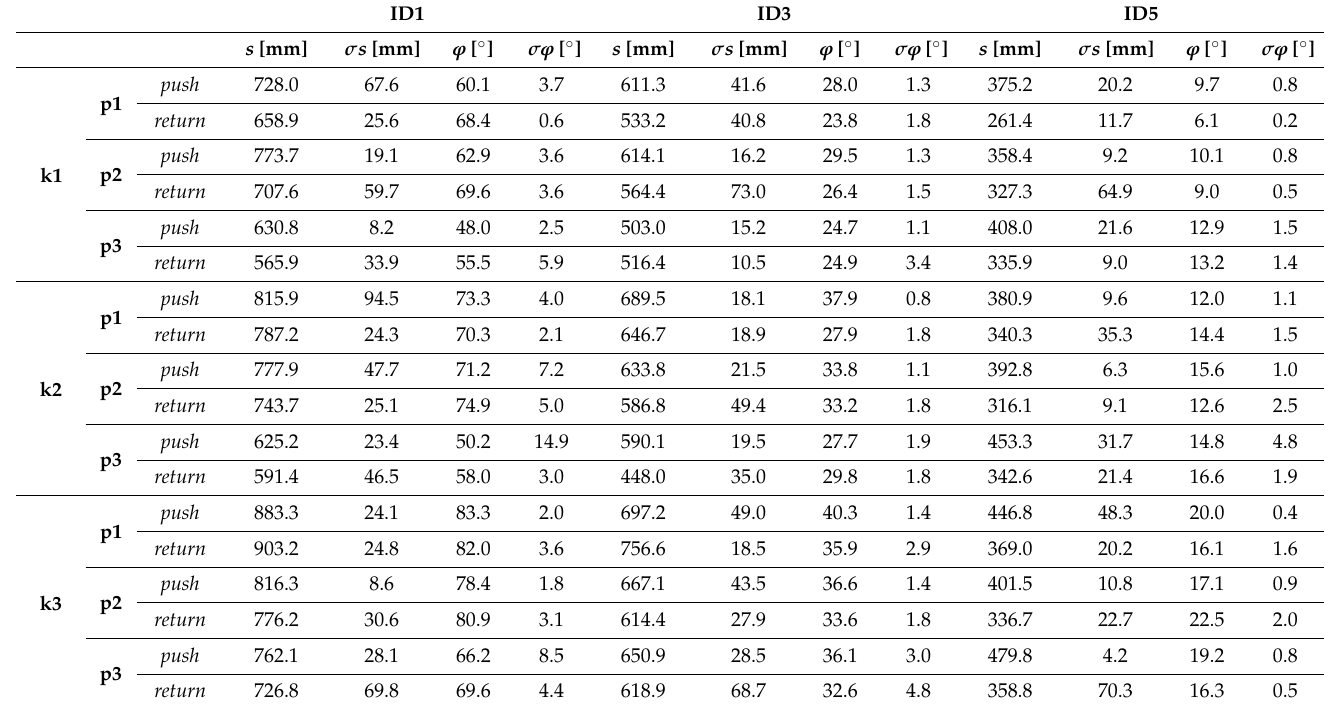
Figure 12. The displacement of individual markers for a constant inclination angle of the wheelchair and a variable gear ratio. Table 5. Mean values of the displacement s and the angle covered by individual markers ϕ ; σ s — standard deviation of the arithmetic mean of the marker’s displacement and σϕ —standard deviation of the arithmetic mean of the angle covered by the marker.